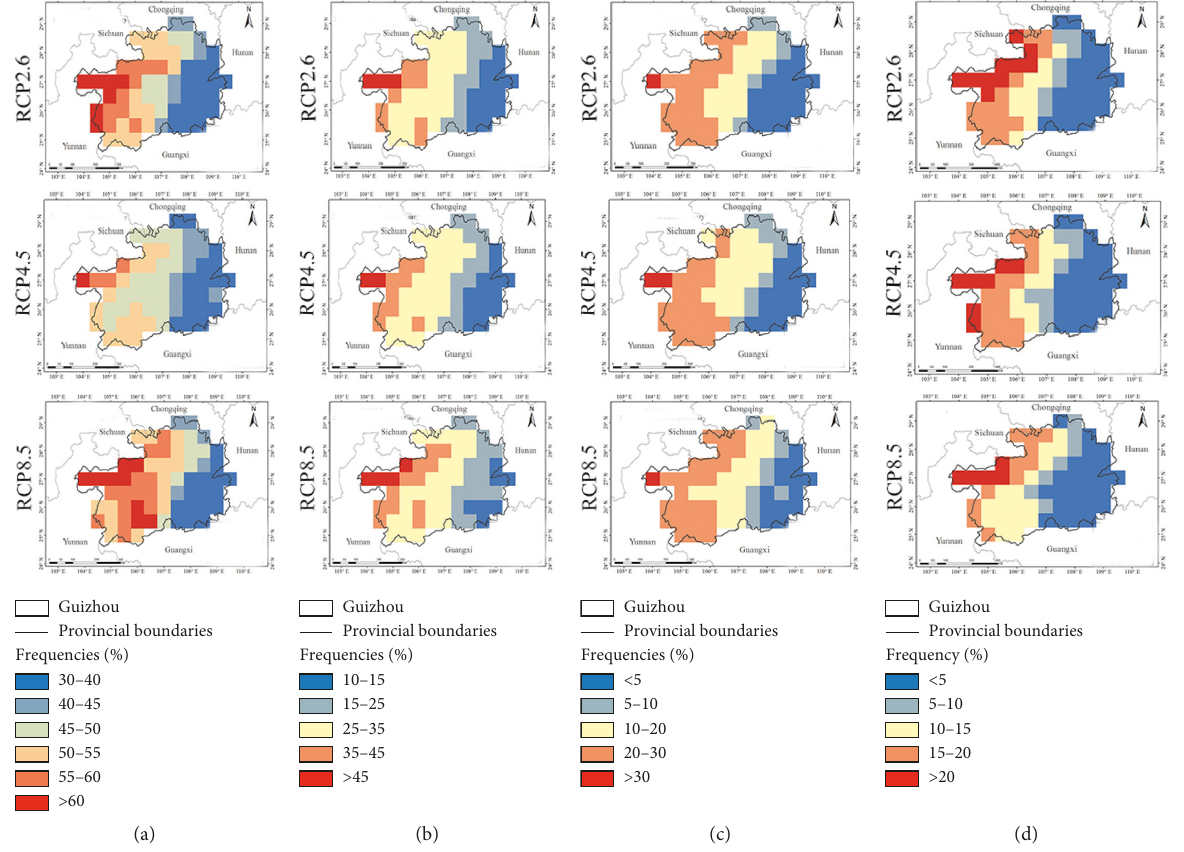
Figure 18: The probabilities of different levels of drought in Guizhou from 2019 to 2050. (a) Light drought. (b) Moderate drought. (c) Severe drought. (d) Extraordinary